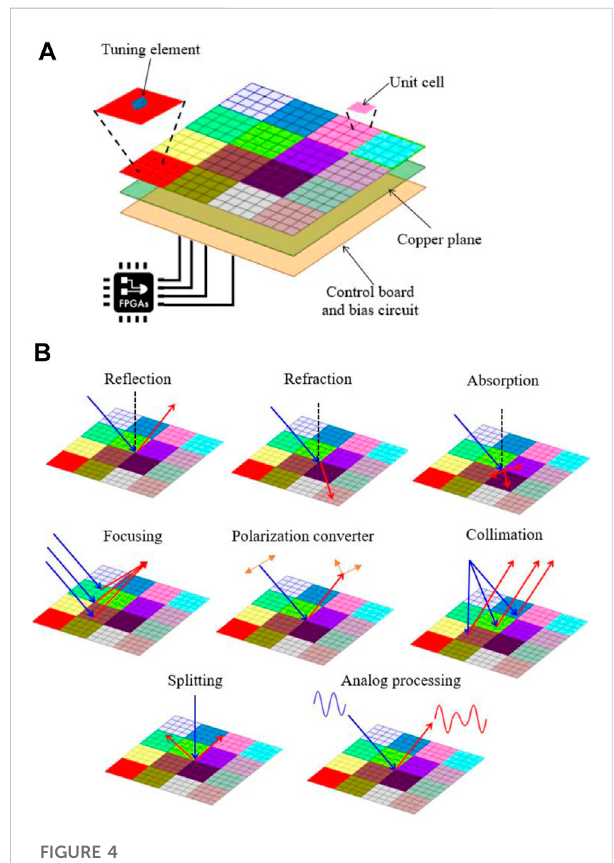
FIGURE 4 Recon fi gurable intelligent surface. (A) Structure layers. (B) Operation